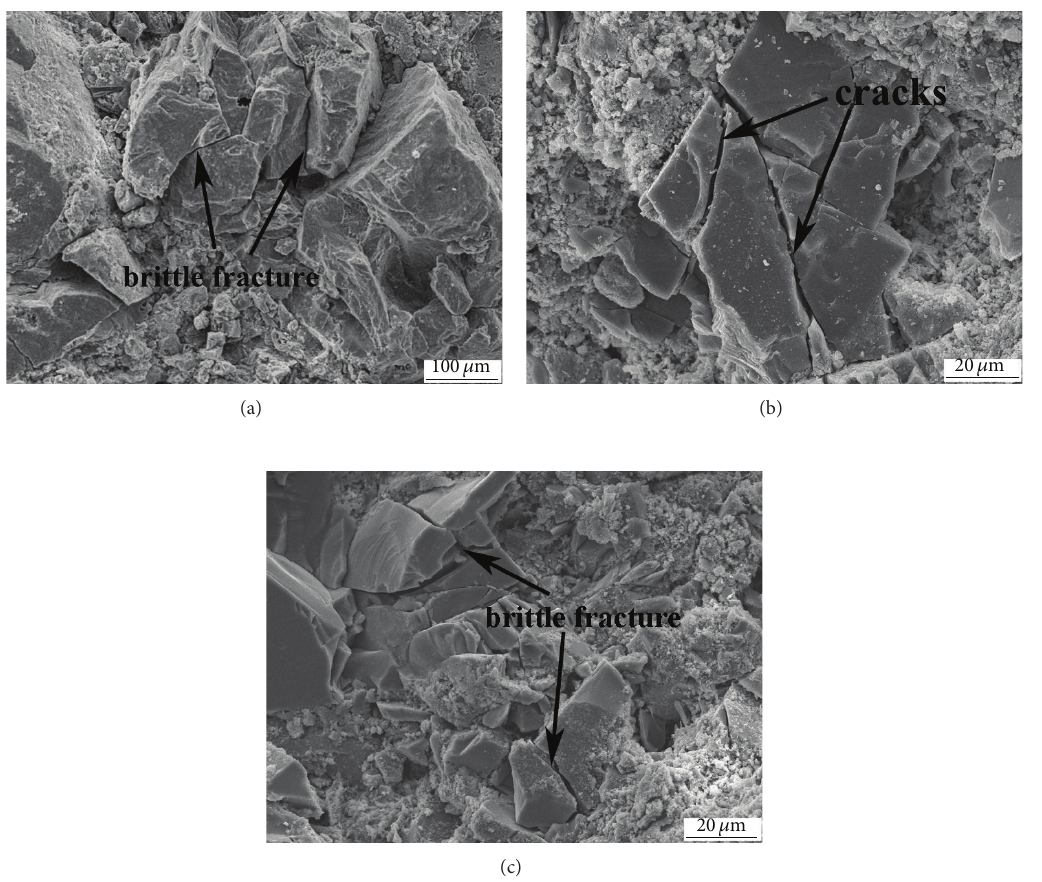
Figure 5: Typical brittle erosion morphologies of aggregate in sample M4 (12% silicon added): (a) eroded at 25 ∘ C; (b) eroded at 800 ∘ C; (c) eroded at 1000 ∘ C.